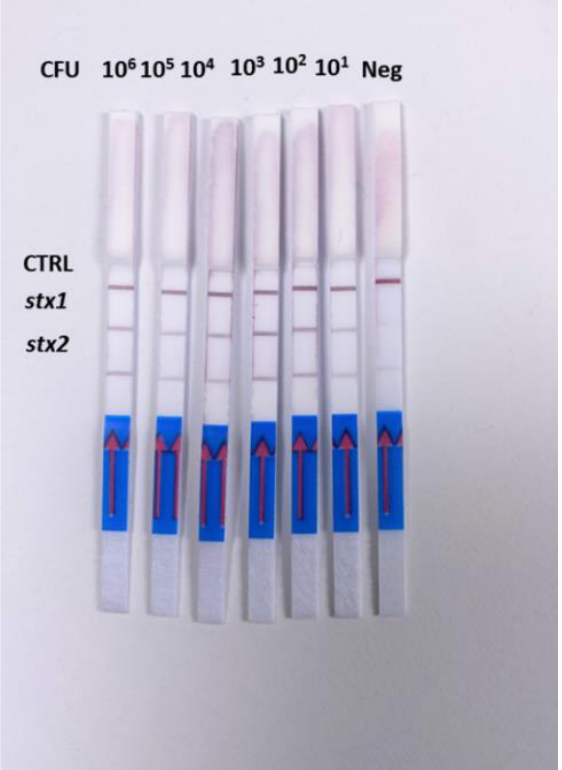
Figure 6. LOD determination in spiked chicken samples. Strips 1 to 7 show varying spiked concen- trations ranging from 10 6 to 10 E. coli O157:H7 with a negative control in strip 7. Results were re- peated in three separate experiments with one representative experiment being